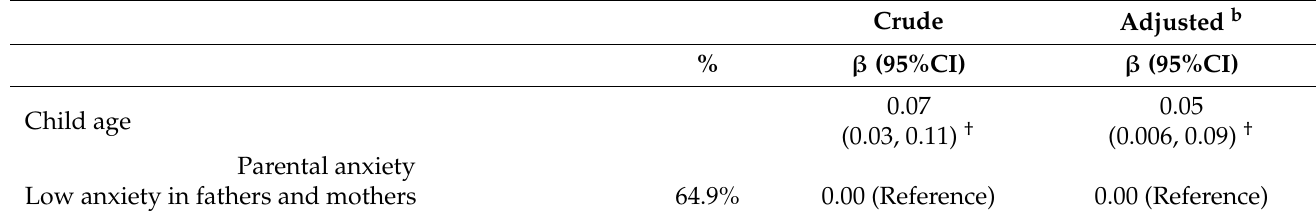
Table 2. Categorical profiles of paternal and maternal anxiety with change in child weight-for-age z-score from the first time point (median age of 4 months) to the third time point (median age of 12 months) in the imputed dataset using GEE a